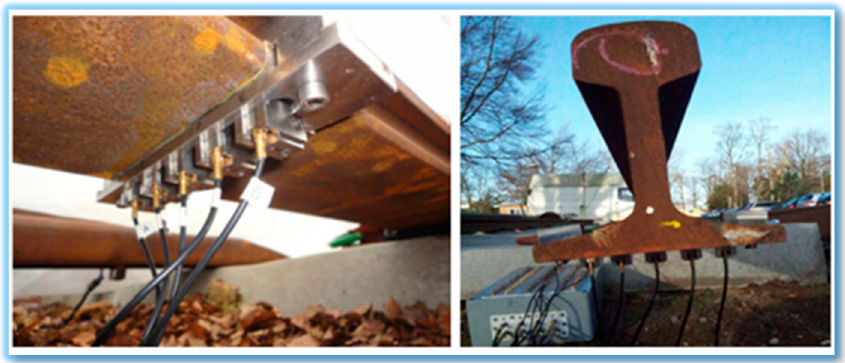
Figure 11. GWUT transducer mounting for rail foot inspections (adapted from [52]).